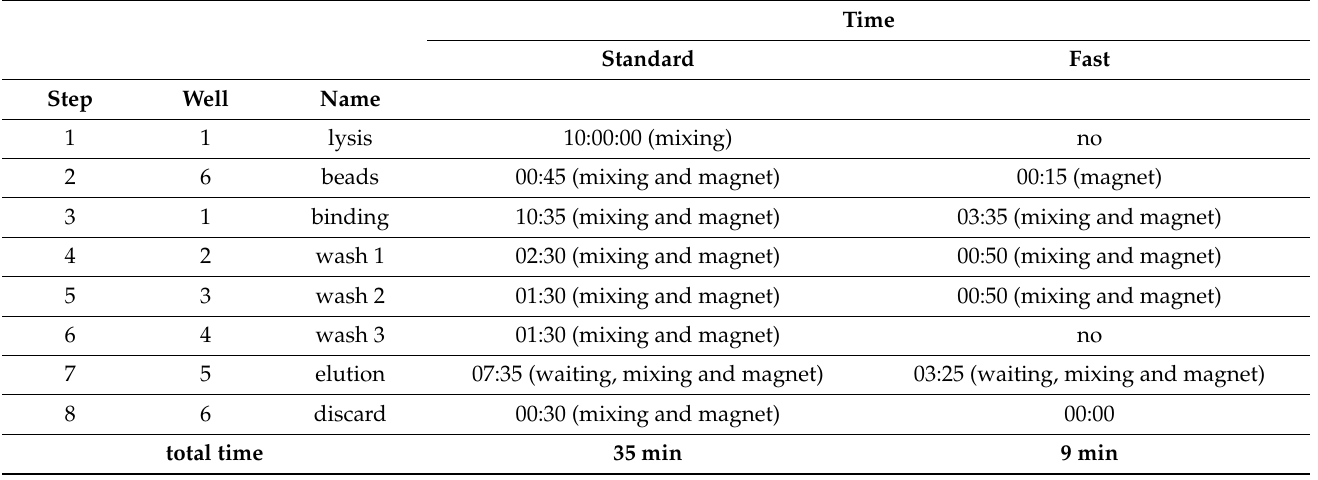
Table 1. Schematic representation of the time consumption in each step for the standard and rapid kit protocols.